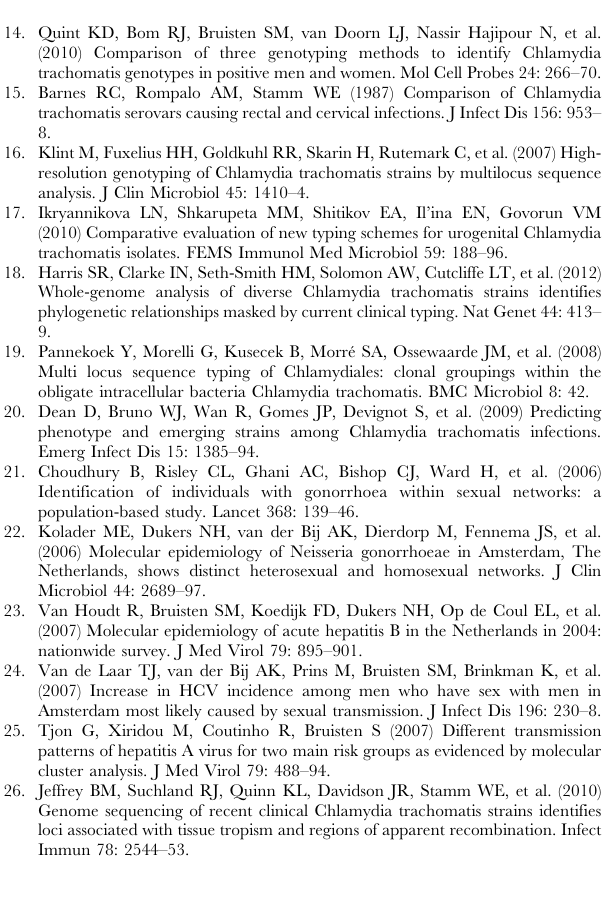
Table S1 MLST-data of the 526 samples collected at the STI outpatient clinic, Amsterdam, July 2008–May 2010. Coding is according to the Chlamydia trachomatis MLST database (mlstdb.bmc.uu.se). The samples are sorted by cluster and sequence